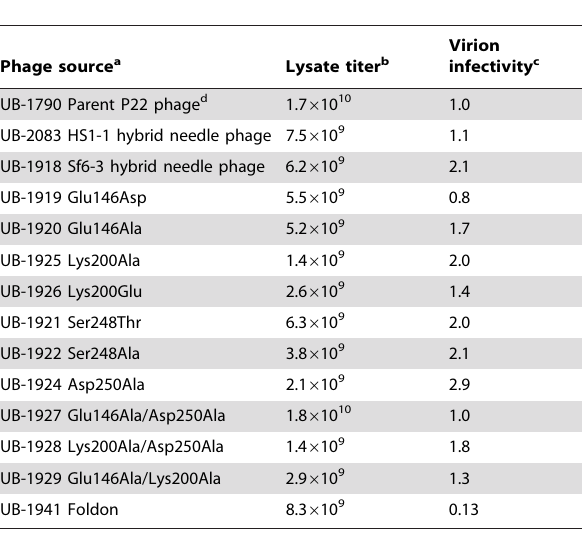
Table 3. Effects of genetic modification the C-terminal needle